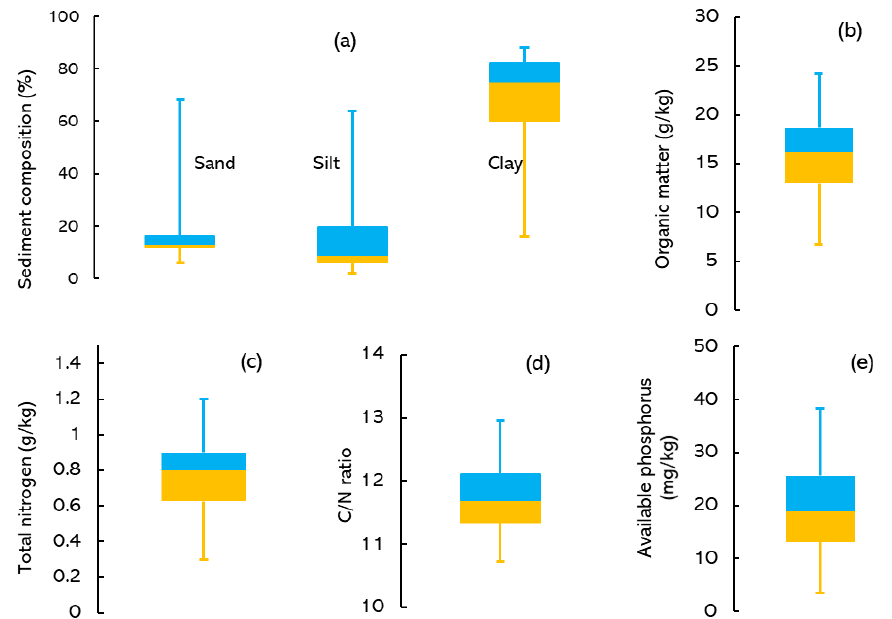
Figure 3. Box plots for bottom sediment characteristics of Lake Tana; ( a ) texture, ( b ) organic matter content, ( c ) total nitrogen, ( d ) C/N, and ( e ) available phosphorus.